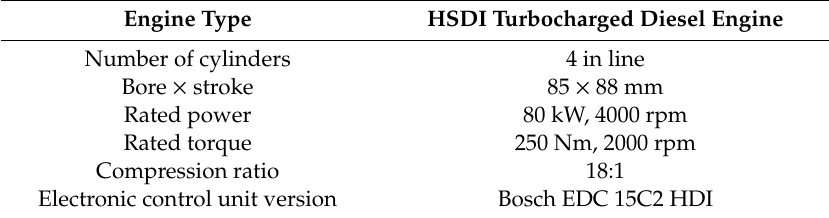
Table 3. Ruggerini RF91 engine specifications.